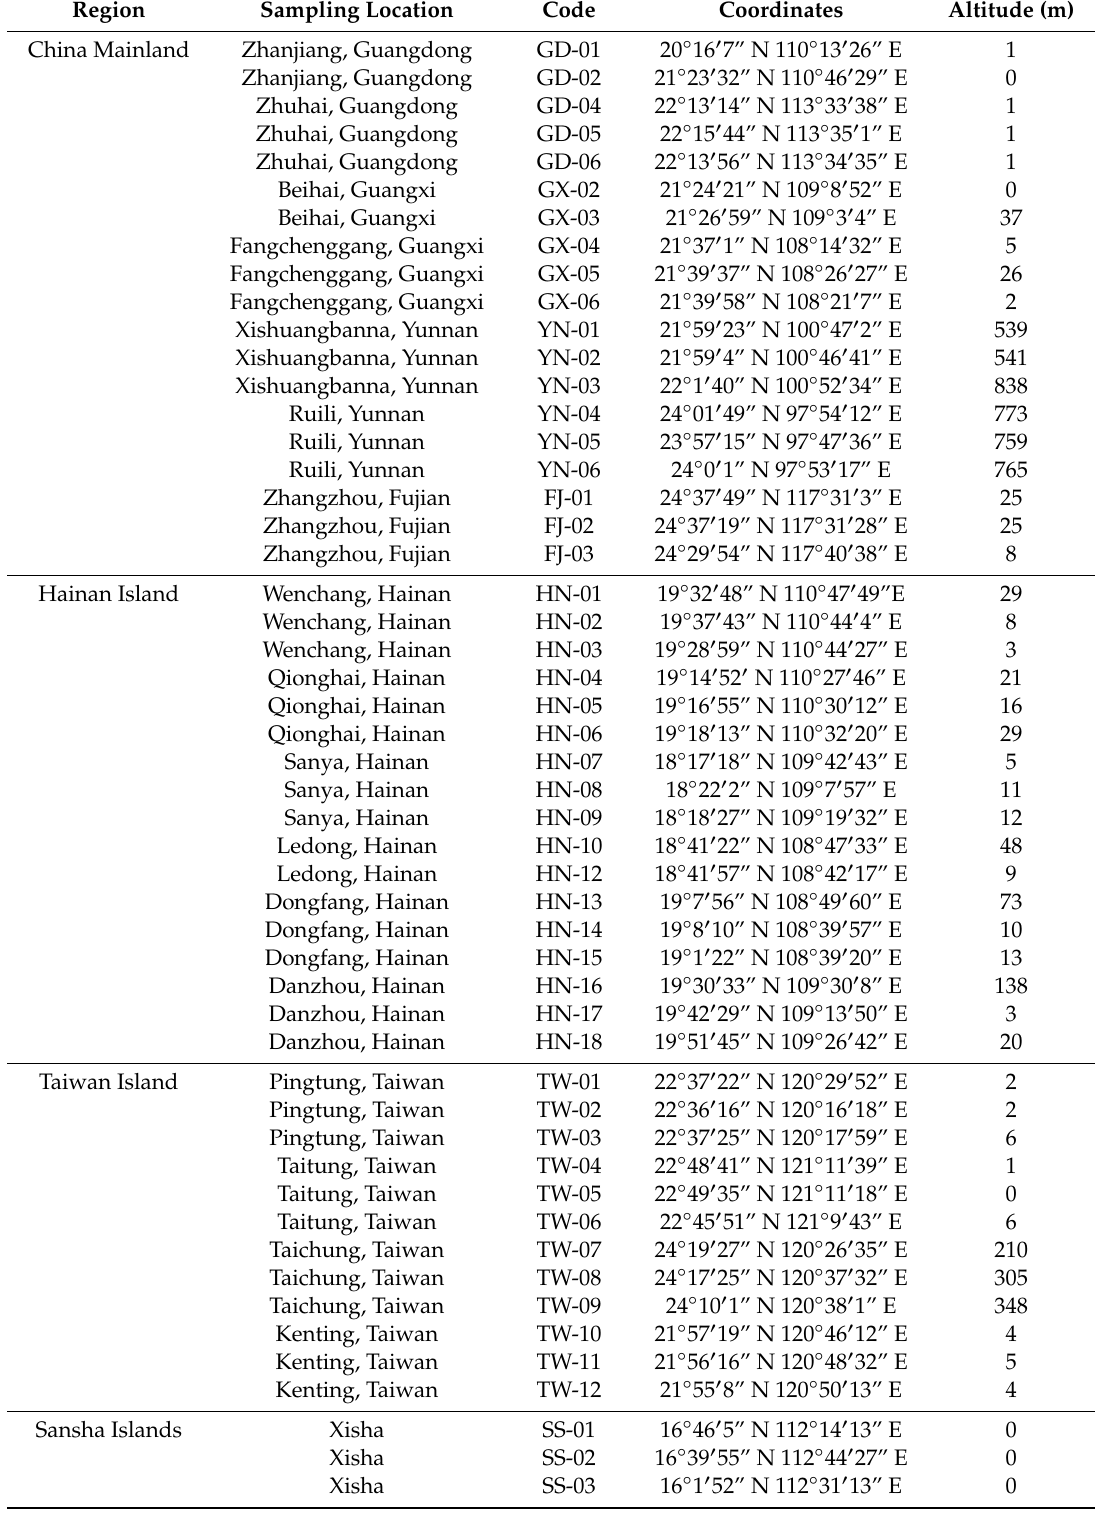
Table 1. Sampling locations and information of B. longissima.